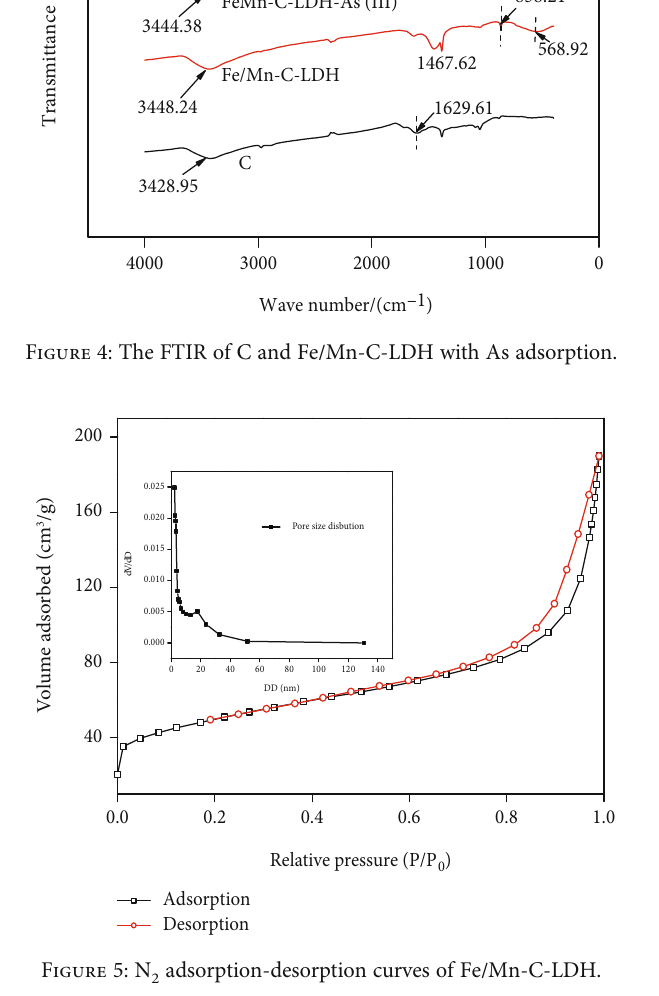
Figure 5: N adsorption-desorption curves of Fe/Mn-C-LDH. 2